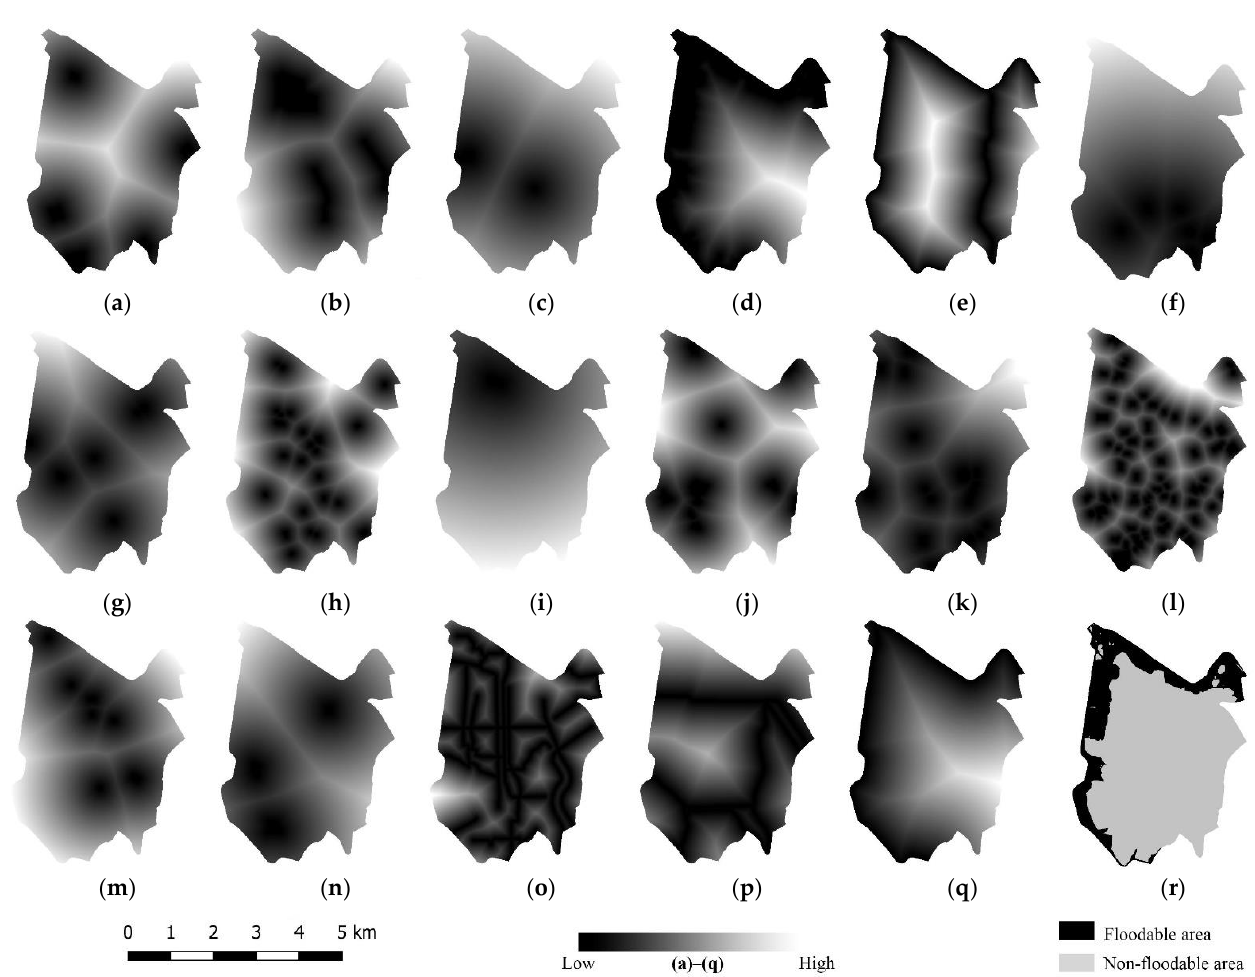
Figure 6. Static driving variables of urban land use change in São Caetano do Sul city associated with distances to: ( a ) college campuses, ( b ) commercial centers, ( c ) shopping centers (only available for